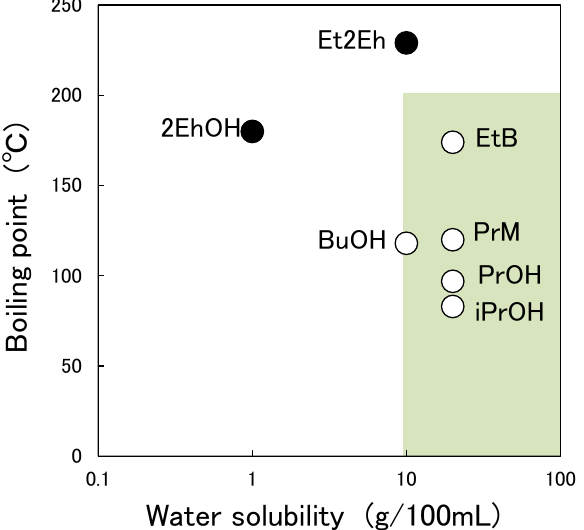
Figure 14. Water solubility at 20 °C and boiling point of the additional solvent allowing switchability and storage stability.